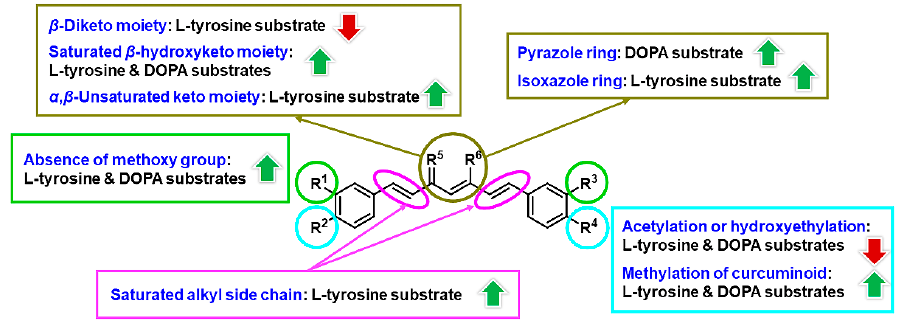
Figure 1. Structure − activity relationship (SAR) analysis of curcuminoids and their analogues. Table 1. Tyrosinase inhibitory activity of natural curcuminoids ( 1 – 3 ) and synthetic analogues ( 4 – 17 ) on L-tyrosine and DOPA sub- strates.